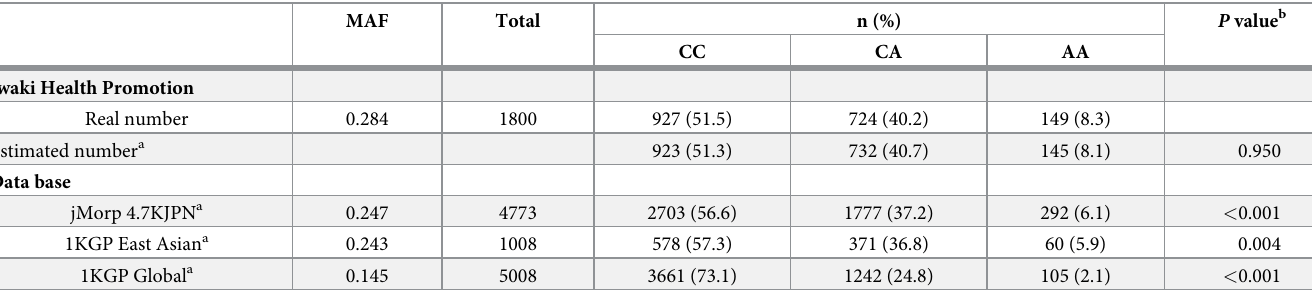
Table 1. The frequency of the NRF2 SNP ( − 617C >